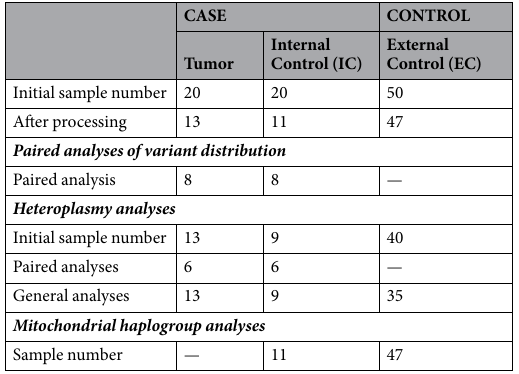
Table 1. Sample number of each group in the different comparison